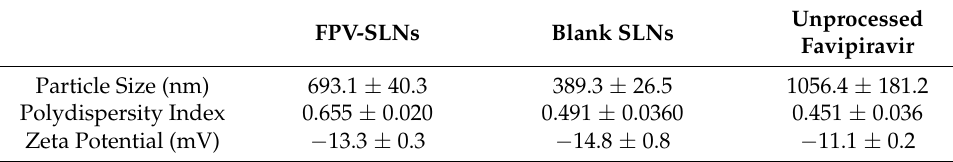
Table 1. Physical characteristics of FPV-SLNs, blank SLNs, and unprocessed favipiravir. FPV-SLNs